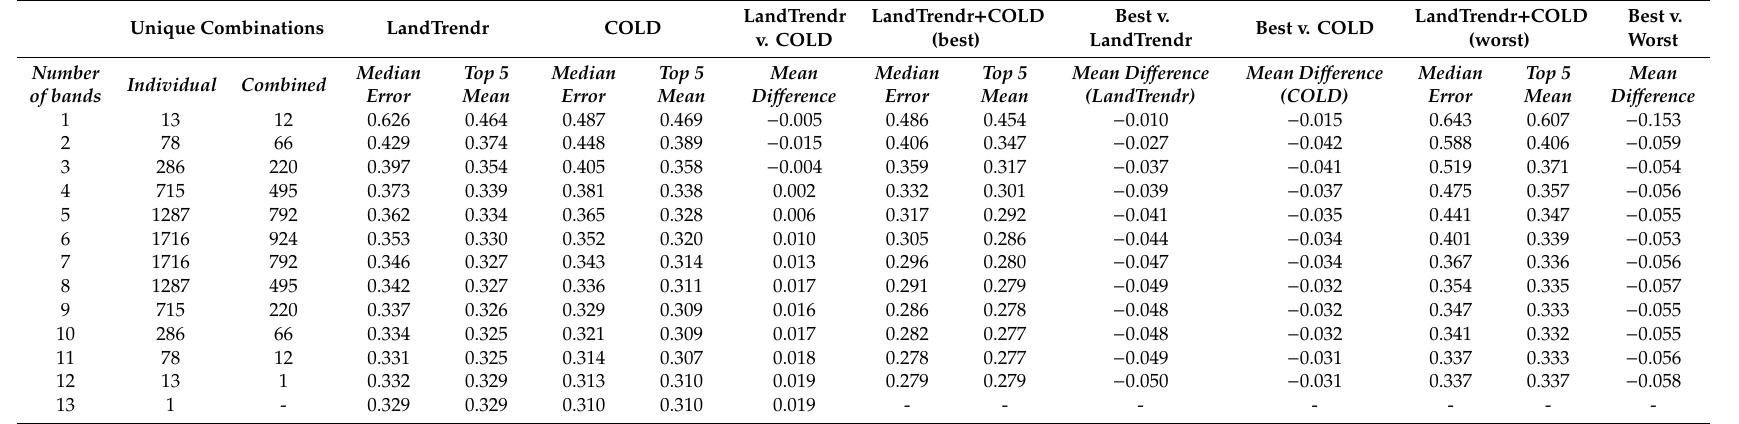
Table 1. Number of bands (N) included for models based on the individual algorithms and their combination, the number of unique band combinations for each N, and balanced error rates for the medians of all models and the means of the top five models for each N. Also shown are error di ff erences for the means of the top five models based on the individual and combined algorithms, using both the six best and six worst bands for the combined